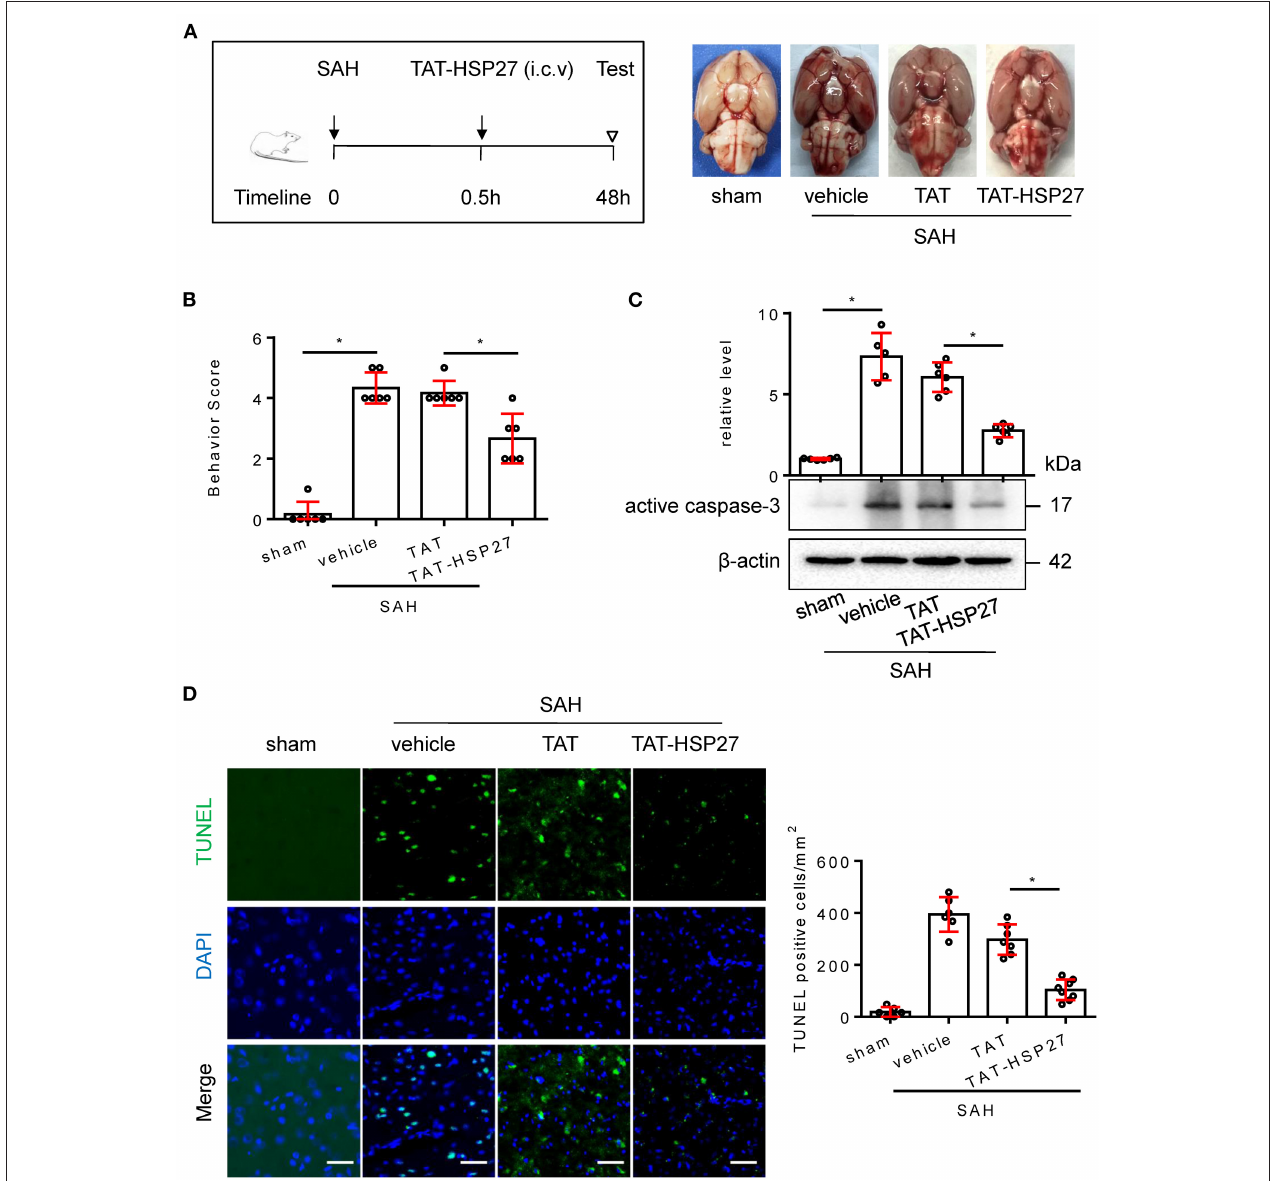
FIGURE 8 | TAT- HSP27 65 − 90 peptide attenuated neurological deficits and cell apoptosis after SAH in rats. (A) Experimental design; representative images of rat brain on day 2 after surgery for the sham, SAH + vehicle, SAH + TAT peptide (SAH + TAT), and SAH + TAT-HSP27 65 − 90 peptide (SAH + TAT-HSP27) groups. (B) Behavior scores of each group were assessed at 48h, n = 6. (C) The basal cortex was collected on day 2 following SAH from the sham ( n = 6), SAH + vehicle ( n = 5), SAH + TAT ( n = 6), and SAH + TAT-HSP27 ( n = 6) groups; homogenates were blotted with anti-active caspase-3 and anti- β -actin, and quantification of optical density was normalized to sham group. (D) Coronal sections from the sham ( n = 6), SAH + vehicle ( n = 6), SAH + TAT ( n = 7), and SAH + TAT-HSP27 ( n = 8) group reperfusion on day 2 after SAH, subjected to immunostaining for the TUNEL (green) in the basal cortex. Quantification was performed by counting the TUNEL positive cells per mm 2 region in the basal cortex, scale bar = 50 µ m. Data are mean ± SD, * p < 0.05 vs. hemolysate treatment, ANOVA with Bonferroni’s multiple comparisons test.